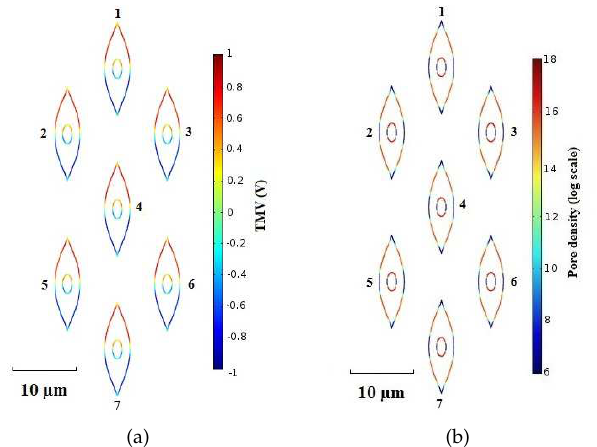
Figure 9. Sparse System—( a ) TMV and ( b ) pore density distribution on cell membranes at time instant t = 20 ns. Pulse amplitude and duration equal to 100 kV/cm and 10 ns, respectively.